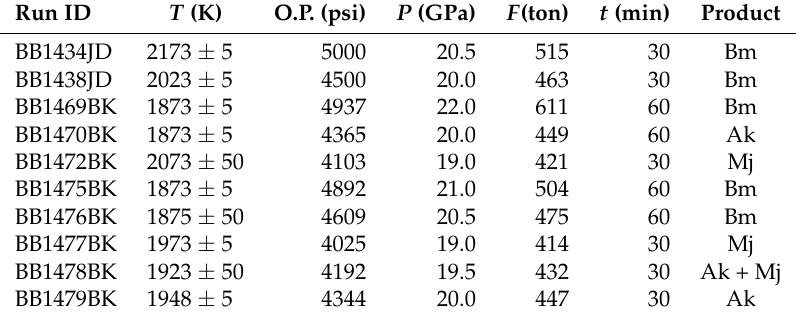
Table 1. Large-volume press runs performed in this study: Estimated uncertainty for pressure is 0.5GPa. Estimated uncertainty without the pressure effects on thermocouple is 5 K. We assigned an uncertainty of ± 50 K for the runs where we estimated temperature through applied voltage calibrated for thermocouple. T : temperature, P : pressure, O.P.: oil pressure, F : force in metric tons, t : heating duration. Run